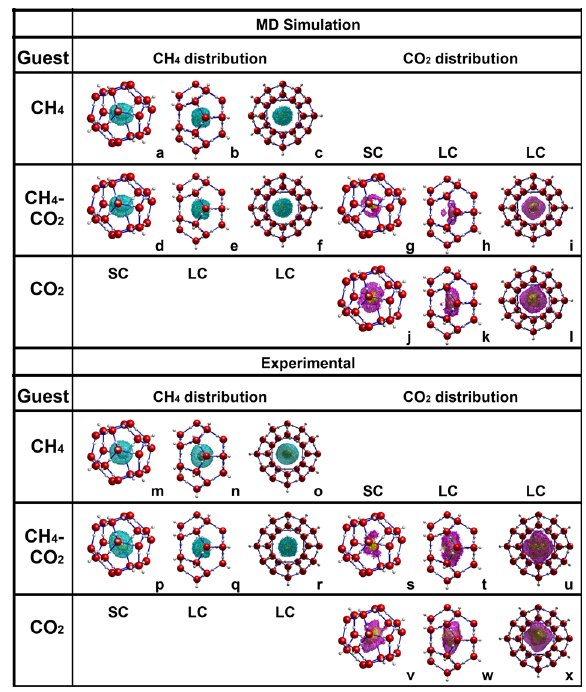
Fig. 4 Distribution of CH 4 and CO 2 in cages. Three-dimensional distributions, calculated from the trajectory frames from MD simulations ( a – l ) and from the sampled frames from the RMC fi ts ( m – x ) that were used to make the